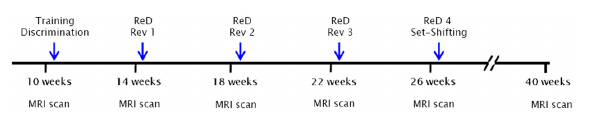
FIGURE 1 | Timeline of the experimental design. Six MRI time points were analyzed that corresponded to 10, 14, 18, 22, 26, and 40 weeks of age. The blue arrows indicate the cognitive tests that started a week after each MRI scan. All 23 animals (11 control and 12 SHR) underwent the MRI scans. Of those same animals, 16 (8 control and 8 SHR) performed the behavioral tests. ReD, re-discrimination; Rev, reversal learning.